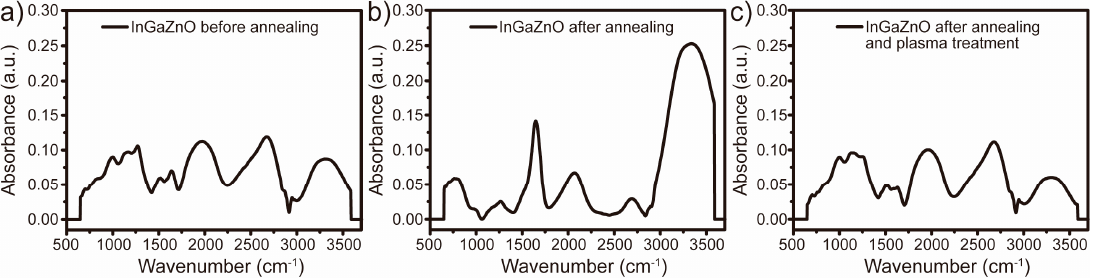
Figure 6. Transmission infrared spectra of InGaZnO films without annealing ( a ), with stepped annealing ( b ), and with stepped annealing and argon plasma treatment ( c ).